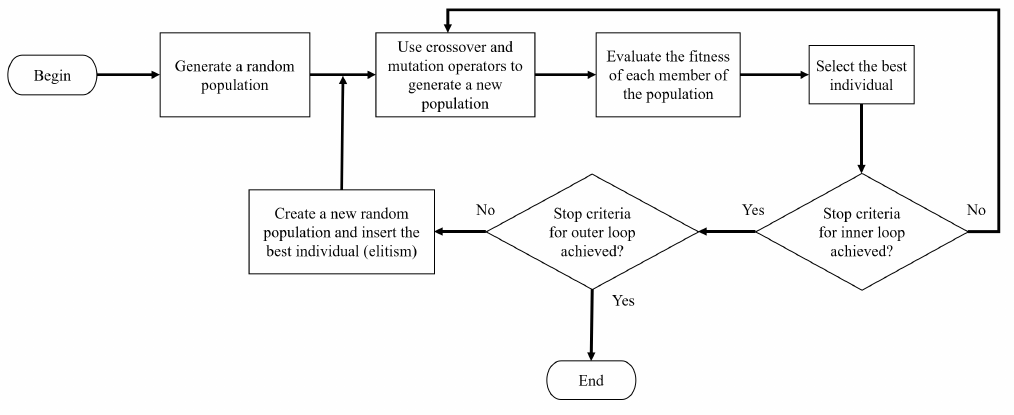
Figure 4. Operation diagram of the